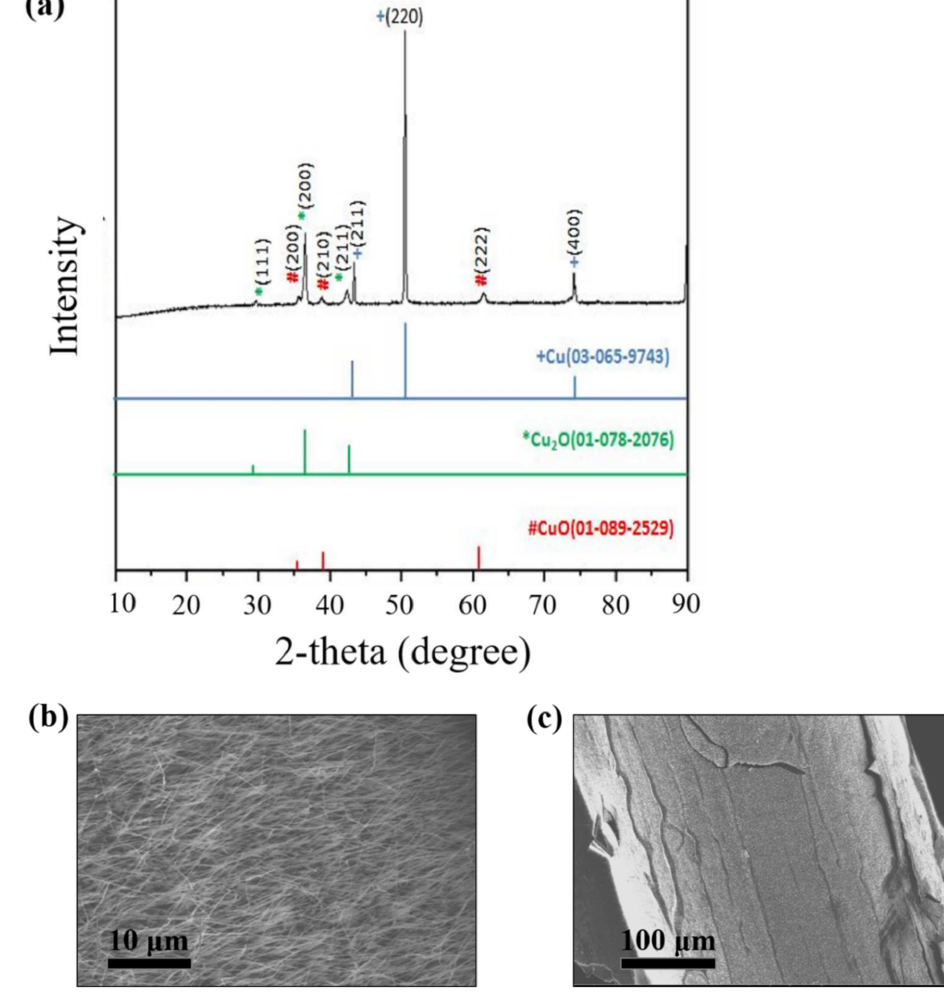
Figure 7. ( a ) XRD plots of the coaxial center copper electrode; ( b ) SEM image of nanowires generated on the surface of the coaxial copper electrode and ( c ) SEM image of the coaxial center copper electrode. Scanning the electron microscopy (SEM) image of the coaxial Cu wire, as shown in Figure 7b, reveals that the nanowires with a 2–2.5 µ m length and a 65–80 nm diameter that are perpendicular to the surface are grown. When the coaxial Cu wire was heated, Cu + was generated, which reacted with the O 2 present in the atmosphere and generated Cu 2 O. Later, Cu 2 O was converted to CuO. The generation of Cu 2 O was in the form of a thin layer, whereas CuO nanowires were grown. According to Wagner’s theory [41], at low temperatures (~0.3–0.5 melting point), a metal is oxidized through the short-circuit diffusion (diffusion along the sub-boundaries, dislocations) of atoms or ions during the reaction in the Cu 2 O layer. The melting temperature of Cu, Cu 2 O and CuO are 1083,